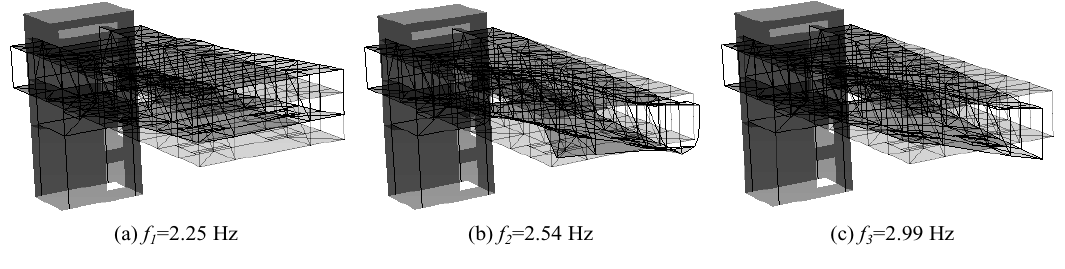
Fig. 6. Measured mode shapes from the modal tests and